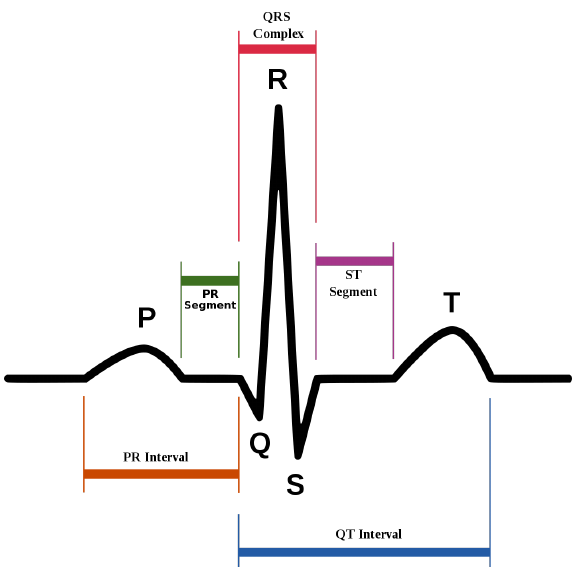
Figure 1. Normal Sinus Rhythm waveform and some of its relevant points